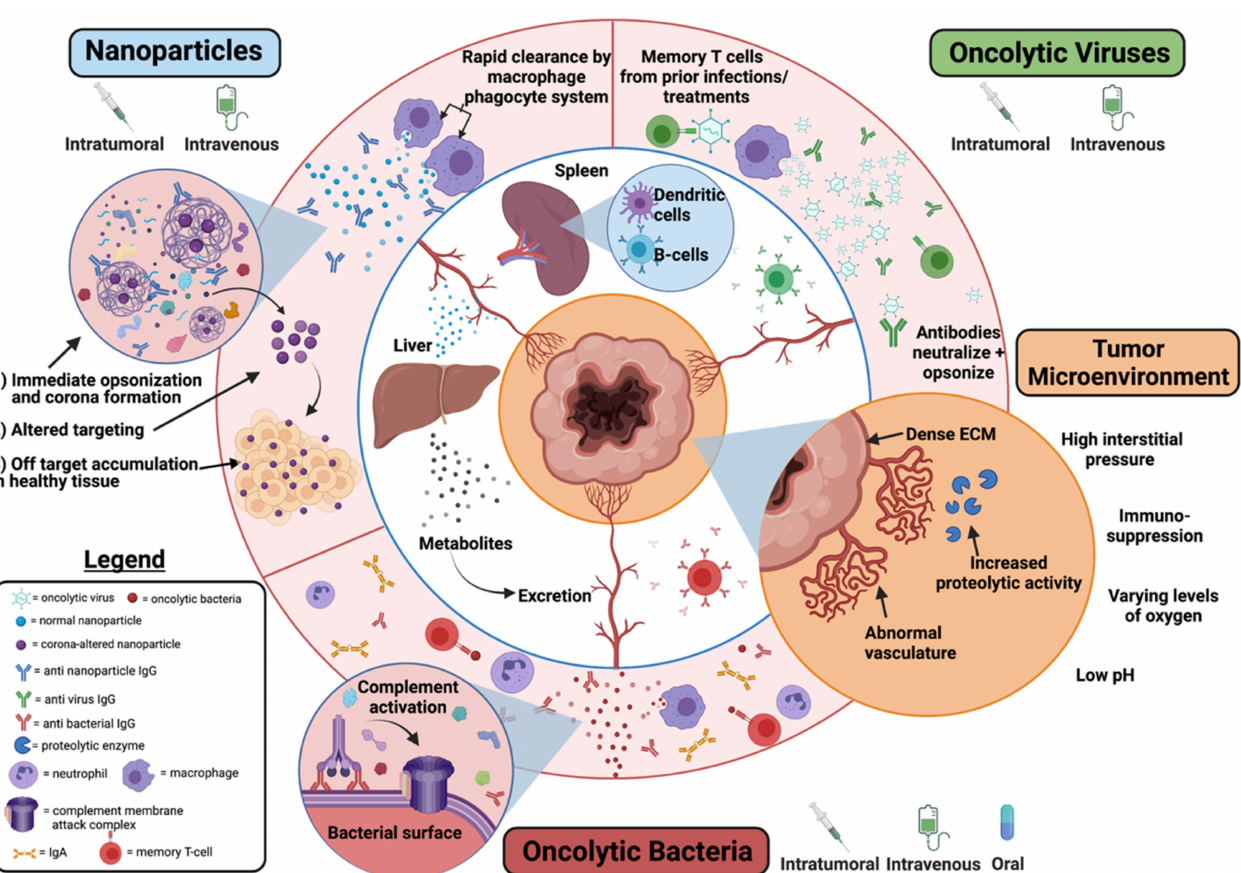
Figure 6. Clearance and biological barriers to novel oncotherapies. The outer ring depicts the initial interactions that occur for each therapeutic as it enters systemic circulation—including corona formation [249,303–305], innate immune responses [311,312], and adaptive immune responses [103,206,235,248,257,318]. Should treatments navigate these obstacles, the tumor microenvironment [133,146,150], metabolic pathways, and adaptive immune responses can complicate current and/or future